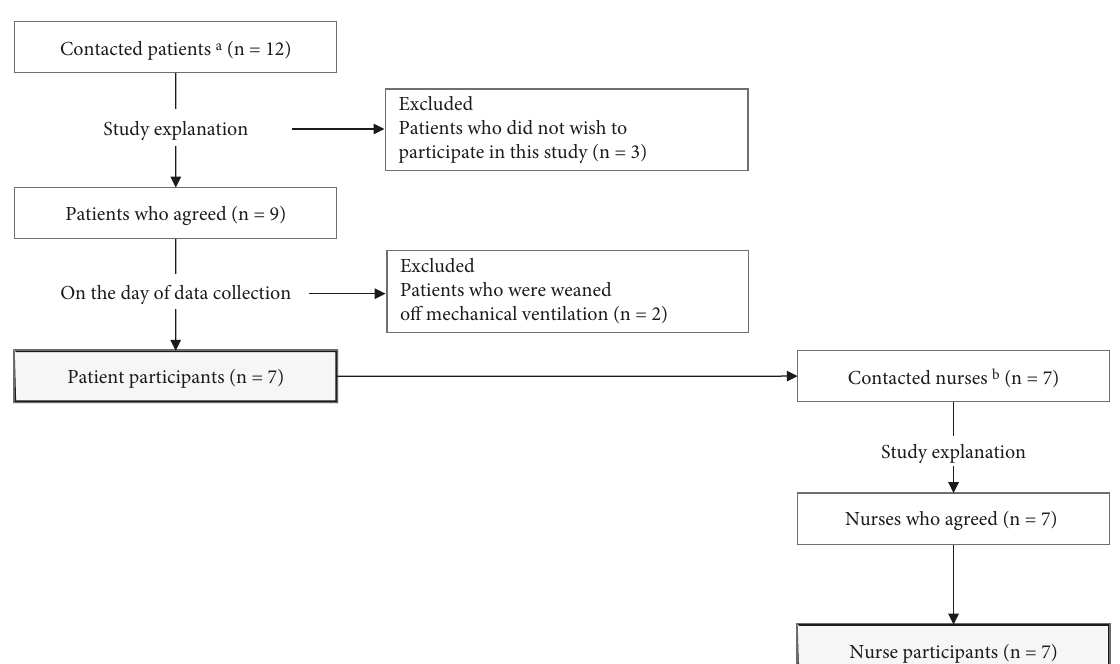
Figure 1: Flowchart of participant recruitment. (a) Contacted patients: patients were already equipped with mechanical ventilation or planned to use mechanical ventilation postoperatively. (b) Contacted nurses: day shift nurses assigned to patients who participated in the